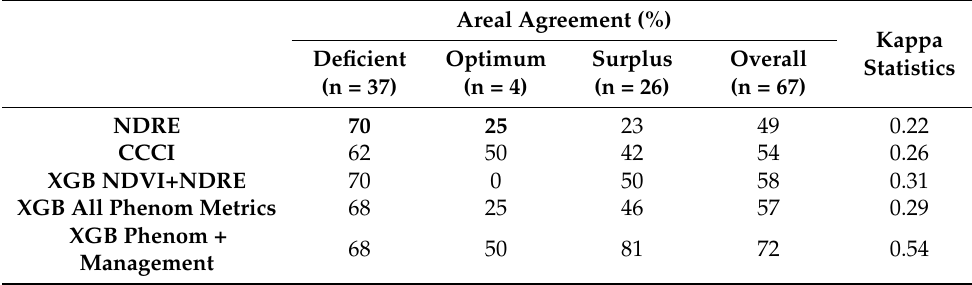
Table 6. Corn N status diagnosis accuracy based on NNI prediction using SR and XGB regression results. Model precision was assessed using areal agreement (%) and kappa statistics (NNI < 0.95